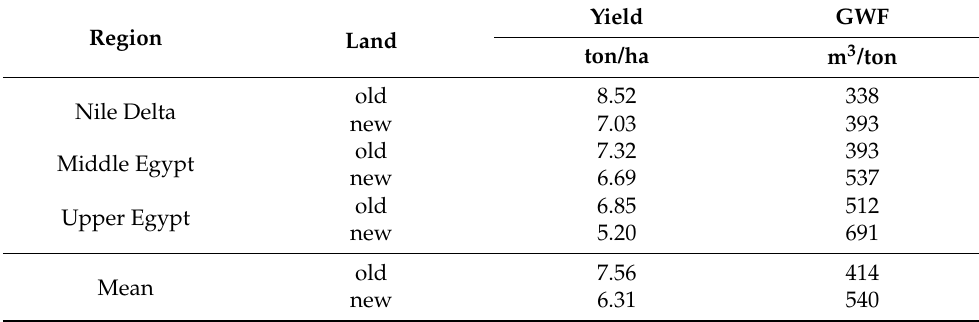
Yield GWF ton/ha m 3 /ton